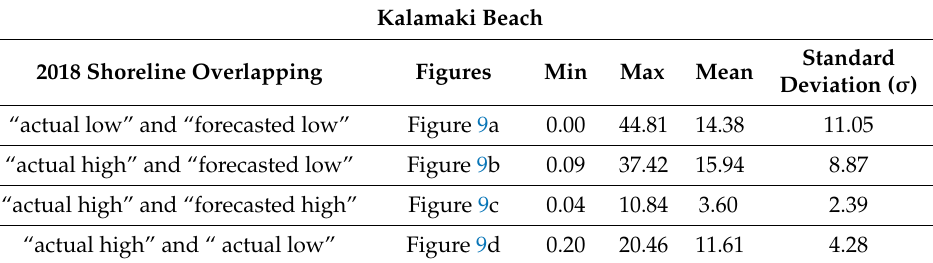
Table 2. SCE statistical rates (in